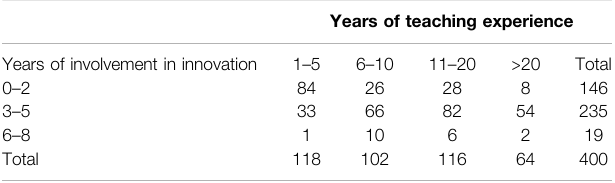
TABLE 3 | Teachers involvement by years of teaching experience and years of involvement in the innovation.